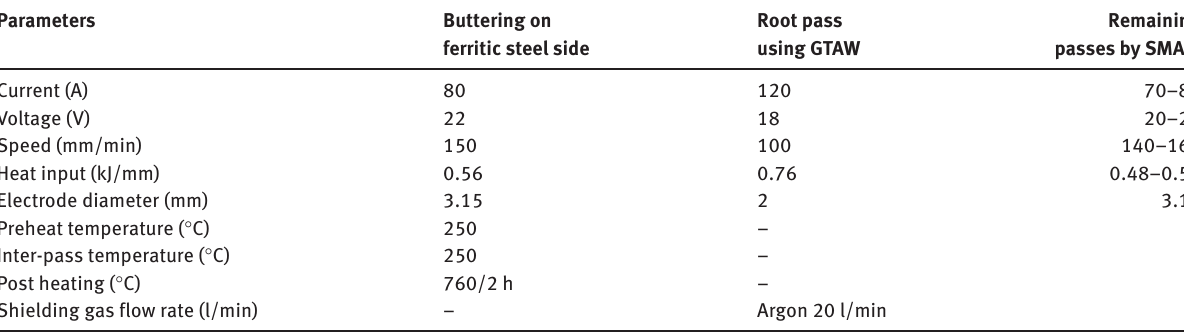
Table 3: Welding parameters used to fabricate the DMWJ.